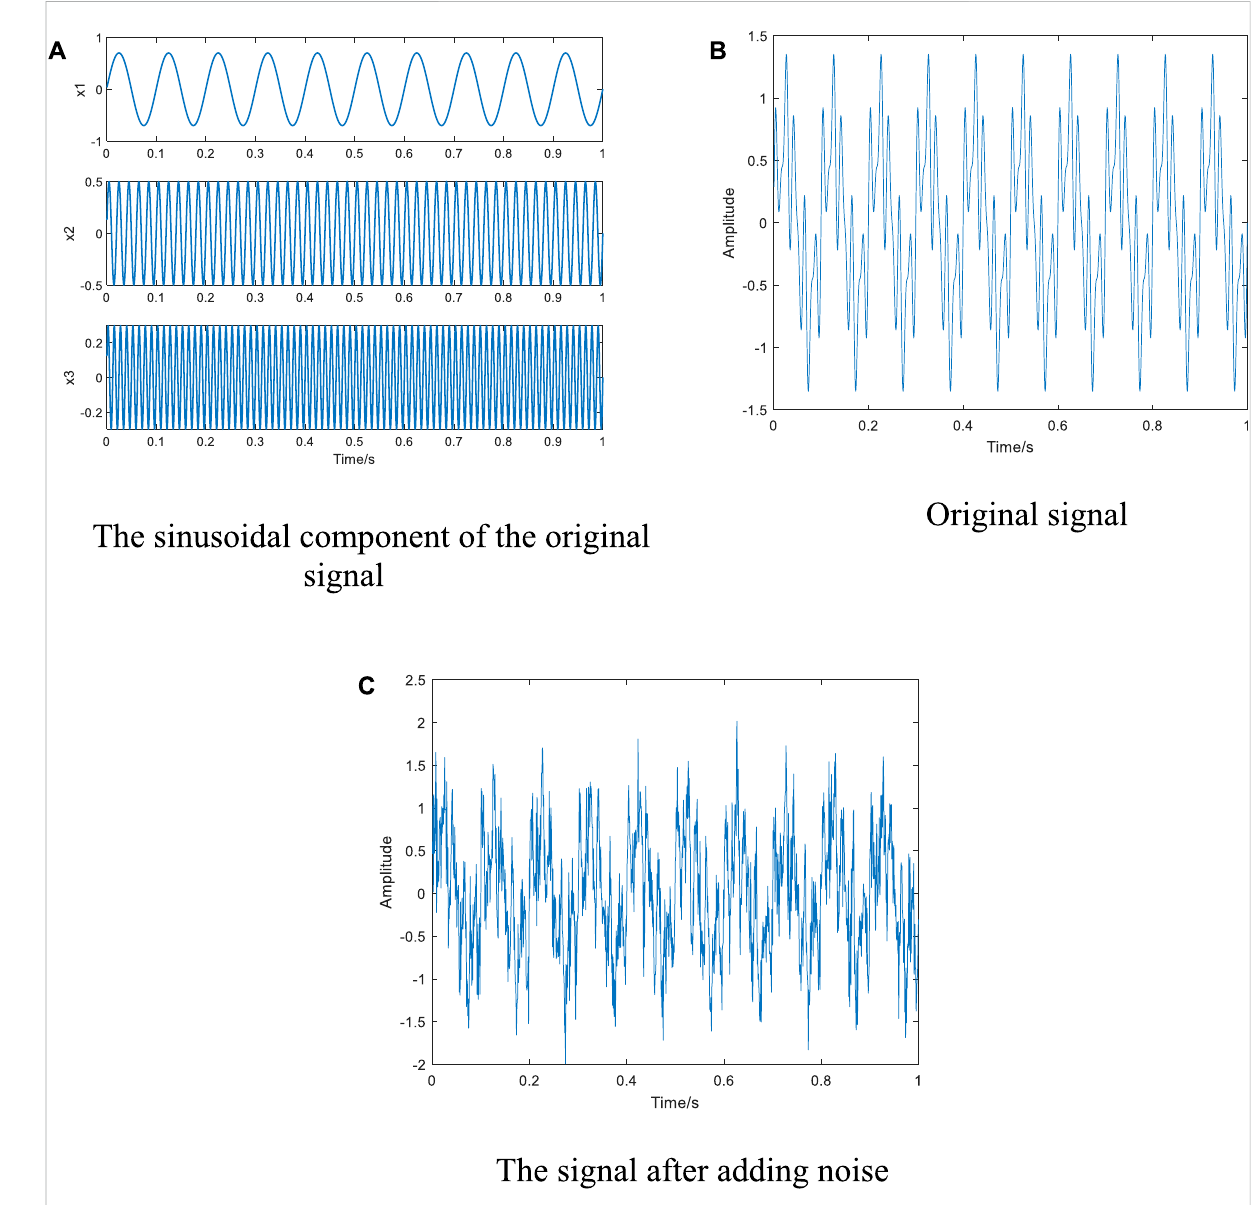
FIGURE 3 The waveform of the simulated signal: (A) The sinusoidal component of the original signal; (B) Original signal; (C) The signal after adding noise.